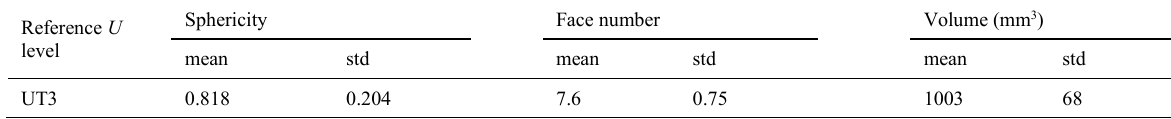
Table 1. The numerical model including the numerical sample, reconstructed fragments and mesh is shown in Fig. 4 (b). Table 1: Interaction property between glass